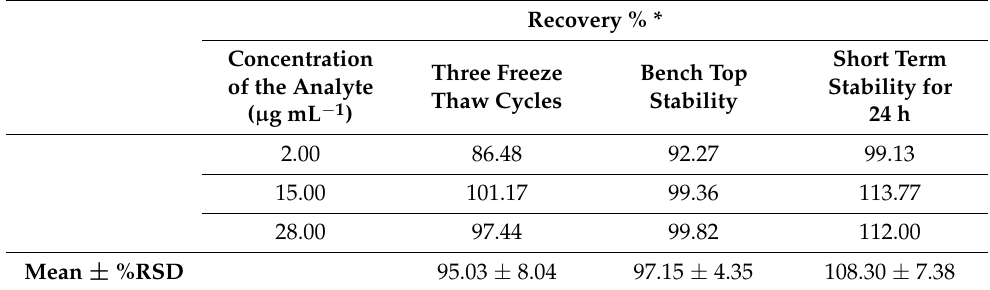
Table 4. Stability results of the studied drugs in spiked human plasma at different conditions.